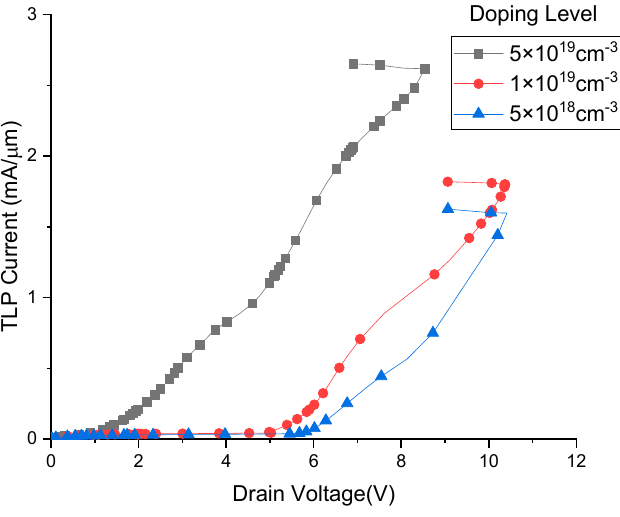
Figure 10. TLP I-V curves of SiGe S/D PNN TFET with different doping Figure 10. TLP I ‐ V curves of SiGe S/D PNN TFET with different doping levels .